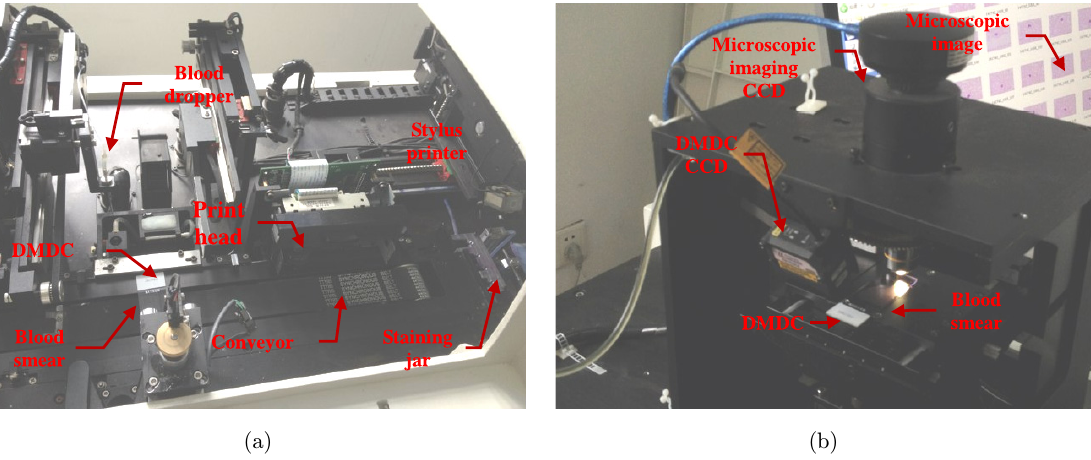
Fig. 14. Experimental system. (a) Part of the blood smear production system and (b) online blood smear microscopic image detection